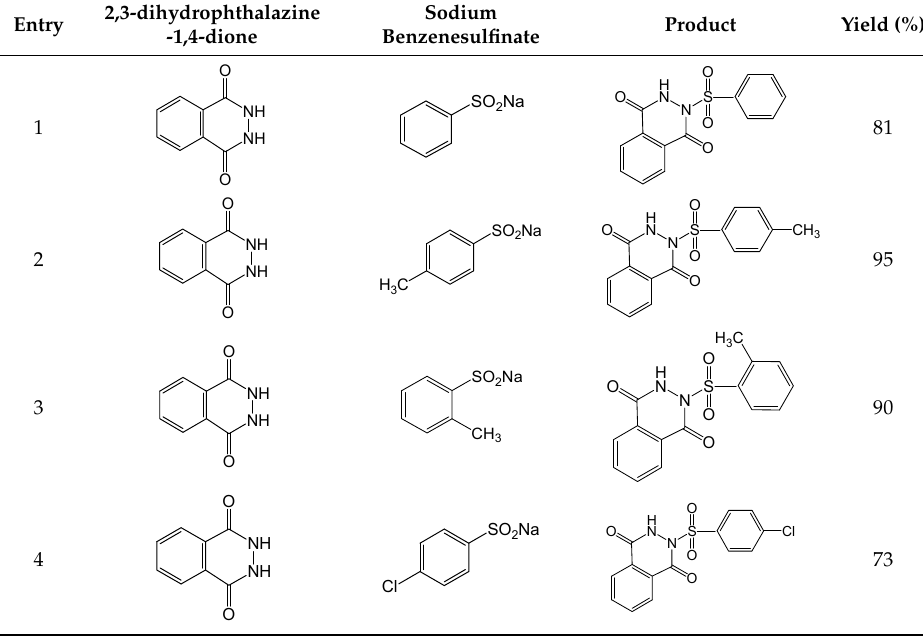
Table 3. Table 3. Table 3. Table 3. Table 3. Synthesis of sulfonamide derivatives in the presence of Lac / Fe 3 O 4 / GO and aerial oxygen at room temperature. Table 3. Synthesis of sulfonamide derivatives in the presence of Lac/Fe 3 O 4 /GO and aerial oxygen at Table 3. Synthesis of sulfonamide derivatives in the presence of Lac/Fe 3 O 4 /GO and aerial oxygen at Table 3. Synthesis of sulfonamide derivatives in the presence of Lac/Fe 3 O 4 /GO and aerial oxygen at Table 3. Synthesis of sulfonamide derivatives in the presence of Lac/Fe 3 O 4 /GO and aerial oxygen at Table 3. Synthesis of sulfonamide derivatives in the presence of Lac/Fe 3 O 4 /GO and aerial oxygen at Table 3. Synthesis of sulfonamide derivatives in the presence of Lac/Fe 3 O 4 /GO and aerial oxygen at room temperature. room temperature. room temperature. room temperature. room temperature. room temperature.